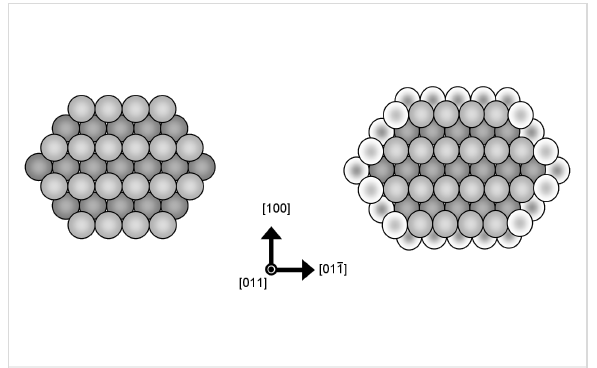
Figure 5: Illustration of a nanowire with fcc crystal structure and hexagonal cross-sectional area for two different diameters: On the right, one further shell is filled with atoms compared to the wire on the